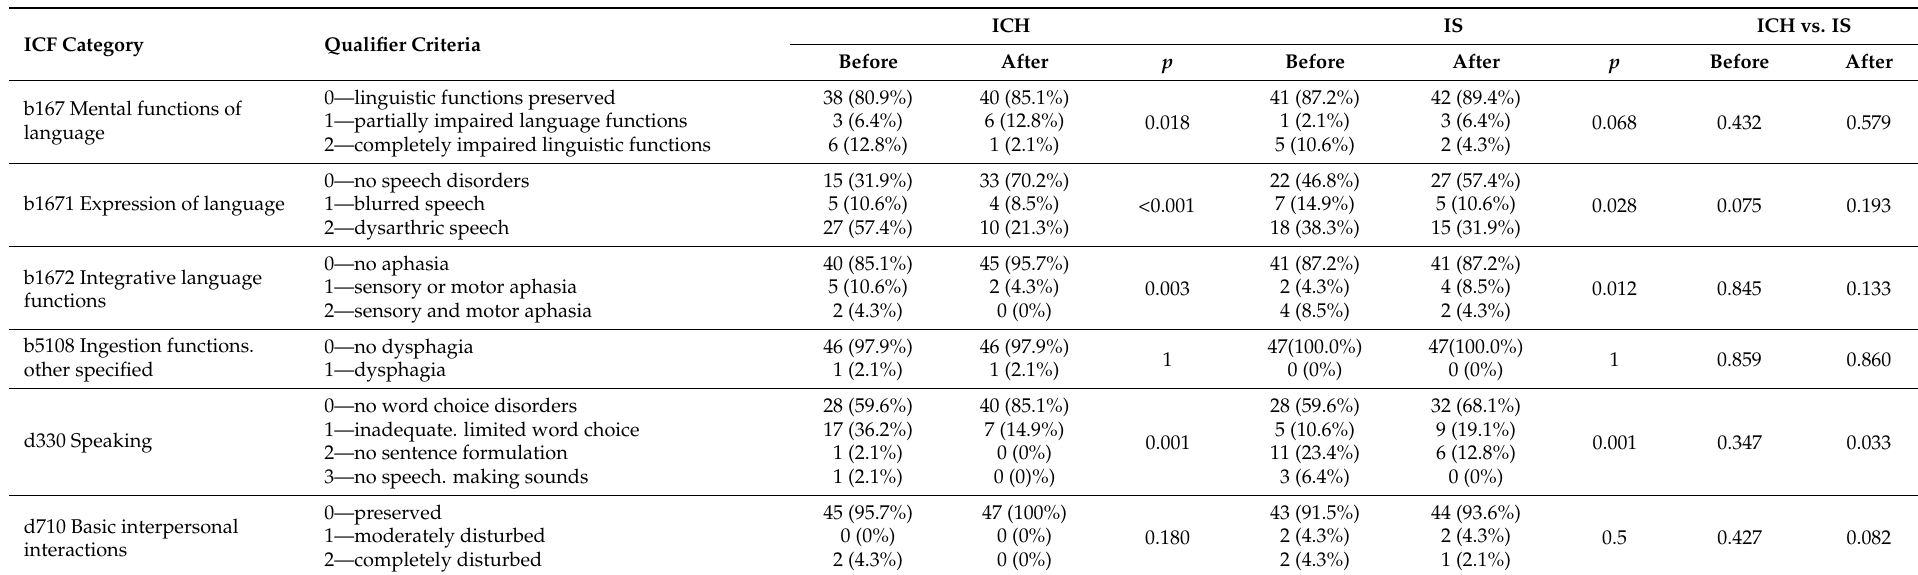
Table 3. Verbal and social communication disorders in patients after ICH and IS before and after